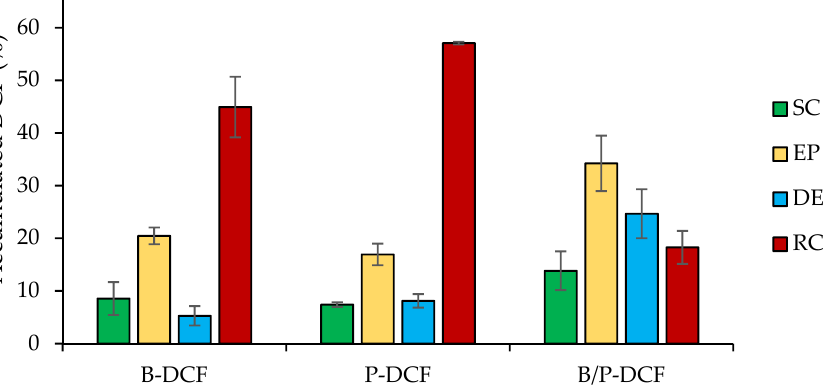
Figure 8. Cumulative amount (%) of DCF retained into and permeated through the skin layers (stratum corneum: SC, epidermis: EP, dermis: DE, and receptor chamber: RC) after 24 h of the application of B-DCF, P-DCF, and B/P-DCF gels (mean values ± s.d.; n = 3). ANOVA one-way; Scheffé test ( p ≤ 0.05): EP: P-DCF vs. B/P-DCF; RC: B-DCF and P-DCF vs. B/P-DCF.